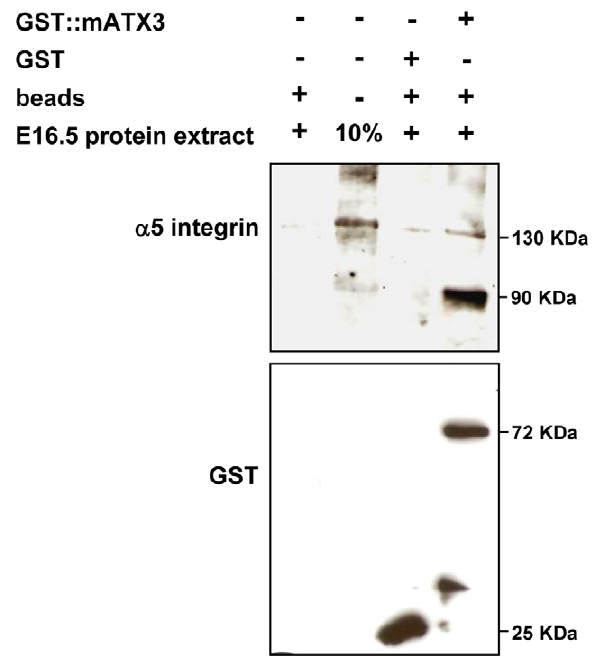
Figure 5. GST-tagged mATX3 pull-downs a 5 integrin subunit from an embryo extract. Purified recombinant GST::mATX3 protein was incubated with a whole protein extract from an E16.5 mouse embryo. Recombinant GST alone was used as control. GST pulled down samples were analyzed by immunoblotting, first with the anti- a 5 integrin antibody, and then with the anti-GST antibody, following stripping. Lane 2 corresponds to 10% of the input where a 5 integrin subunit can be detected as with a band of 130 KDa. Lane 4 shows that GST-mATX3 was able to pull-down a 5 integrin. Note that a band of 90 KDa was also detected, which might correspond to a cleaved product of a 5 integrin generated during the assay. None of the a 5 integrin bands were detected in the controls (lanes 1 and 3: beads alone or beads + GST, respectively).